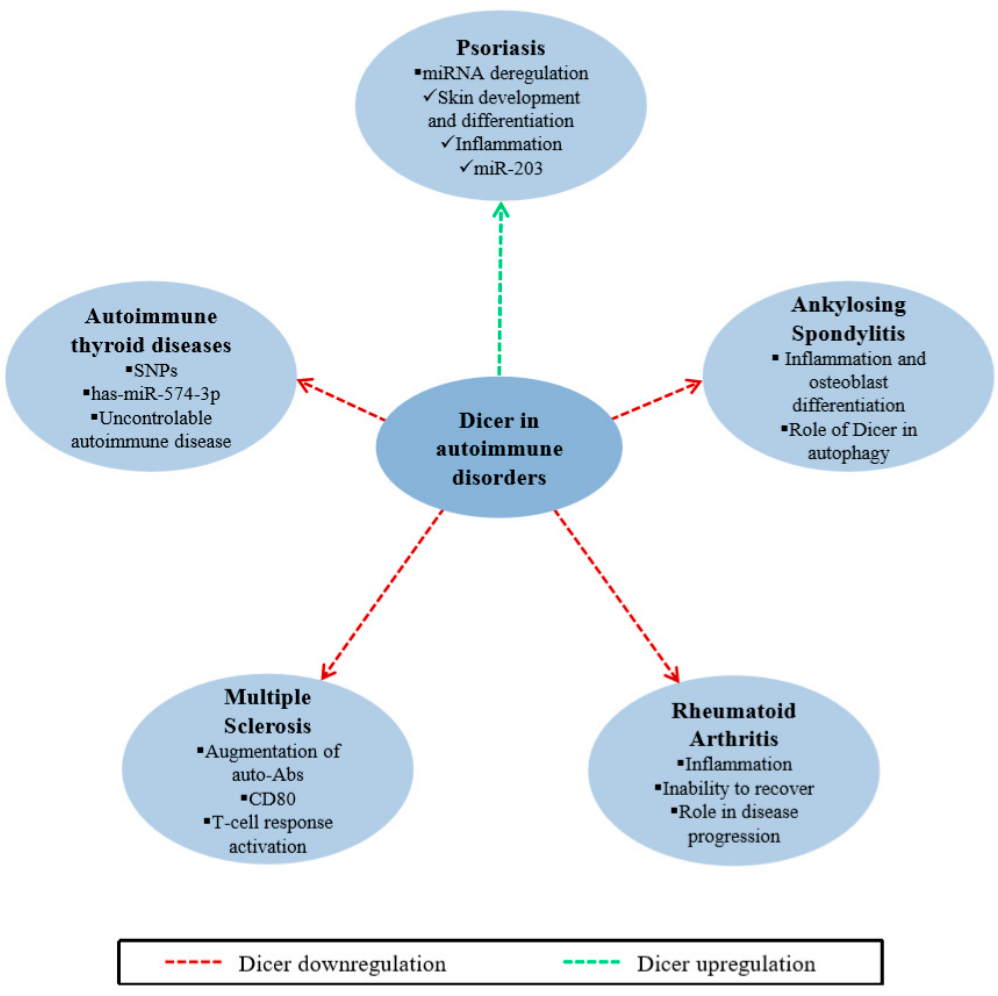
Figure 6. Aberrant expression of Dicer leads to the development of autoimmune disorders. Graphical overview of the main Dicer-associated autoimmune diseases. Both loss and upregulation of Dicer protein expression can cause severe autoimmune disorders, such as psoriasis, ankylosing spondylitis, rheumatoid arthritis, multiple sclerosis and autoimmune thyroid diseases.